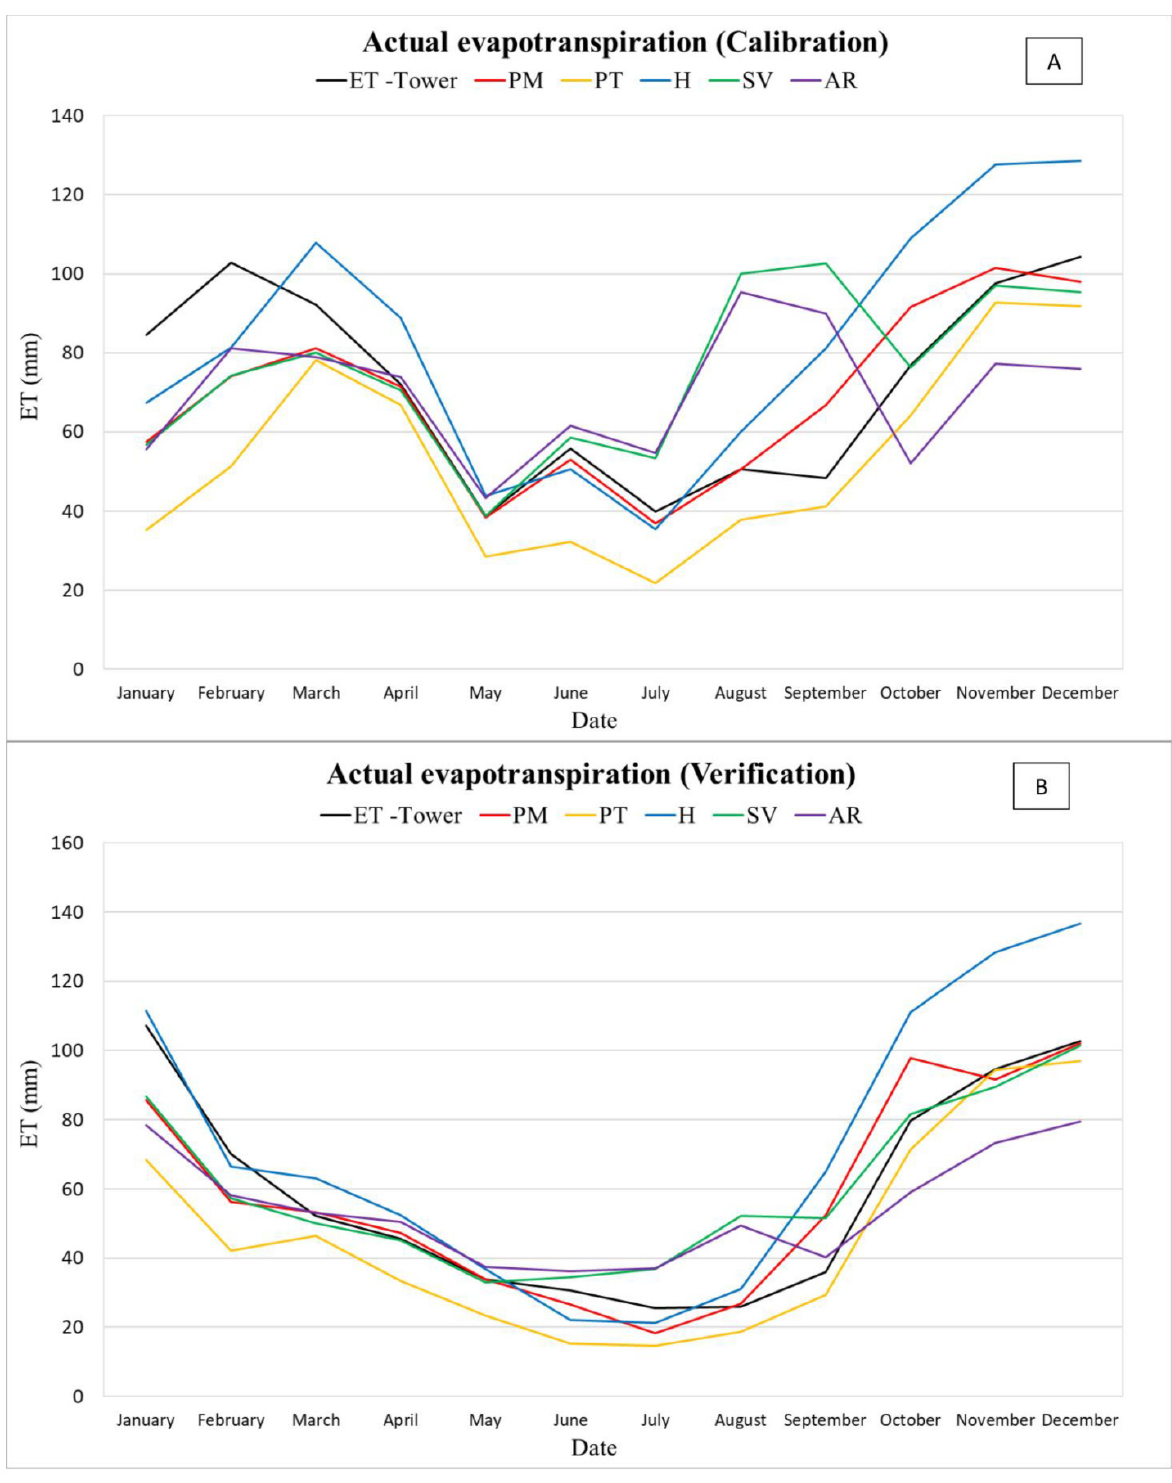
Figure 5. Comparison of the average monthly total actual evapotranspiration for the ( A ) calibration period and ( B ) verification period.